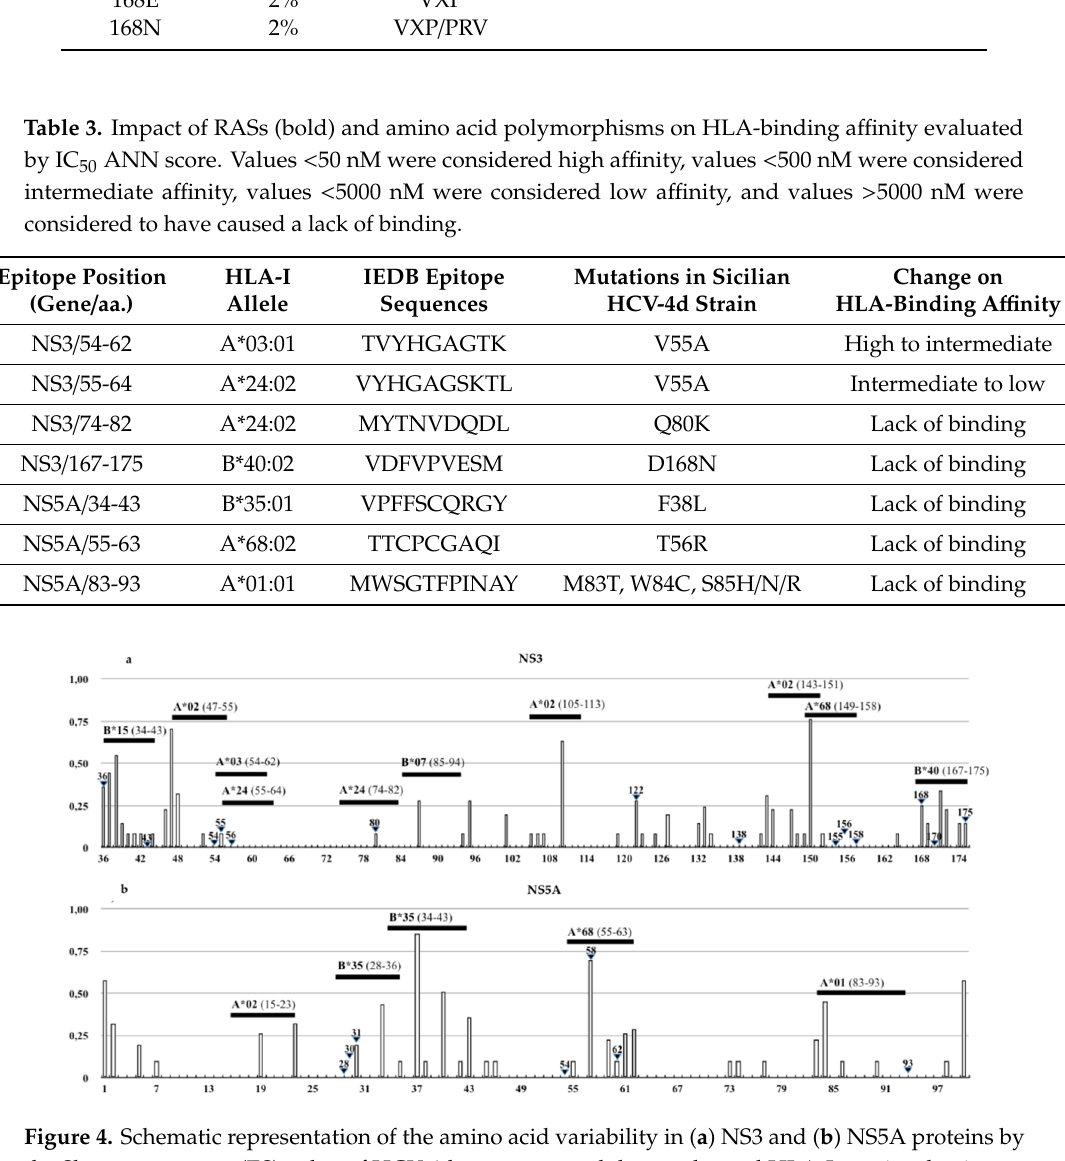
Figure 4. Schematic representation of the amino acid variability in ( a ) NS3 and ( b ) NS5A proteins by the Shannon entropy (ES) value of HCV-4d sequences and the overlapped HLA-I restricted epitopes reported in the IEBD. White vertical bars represent ES values from 0 (low entropy) to 1 (high entropy) and black horizontal bars stand for HLA alleles and HCV epitopes (map positions). Black triangles symbolize residues involved in drug resistance.